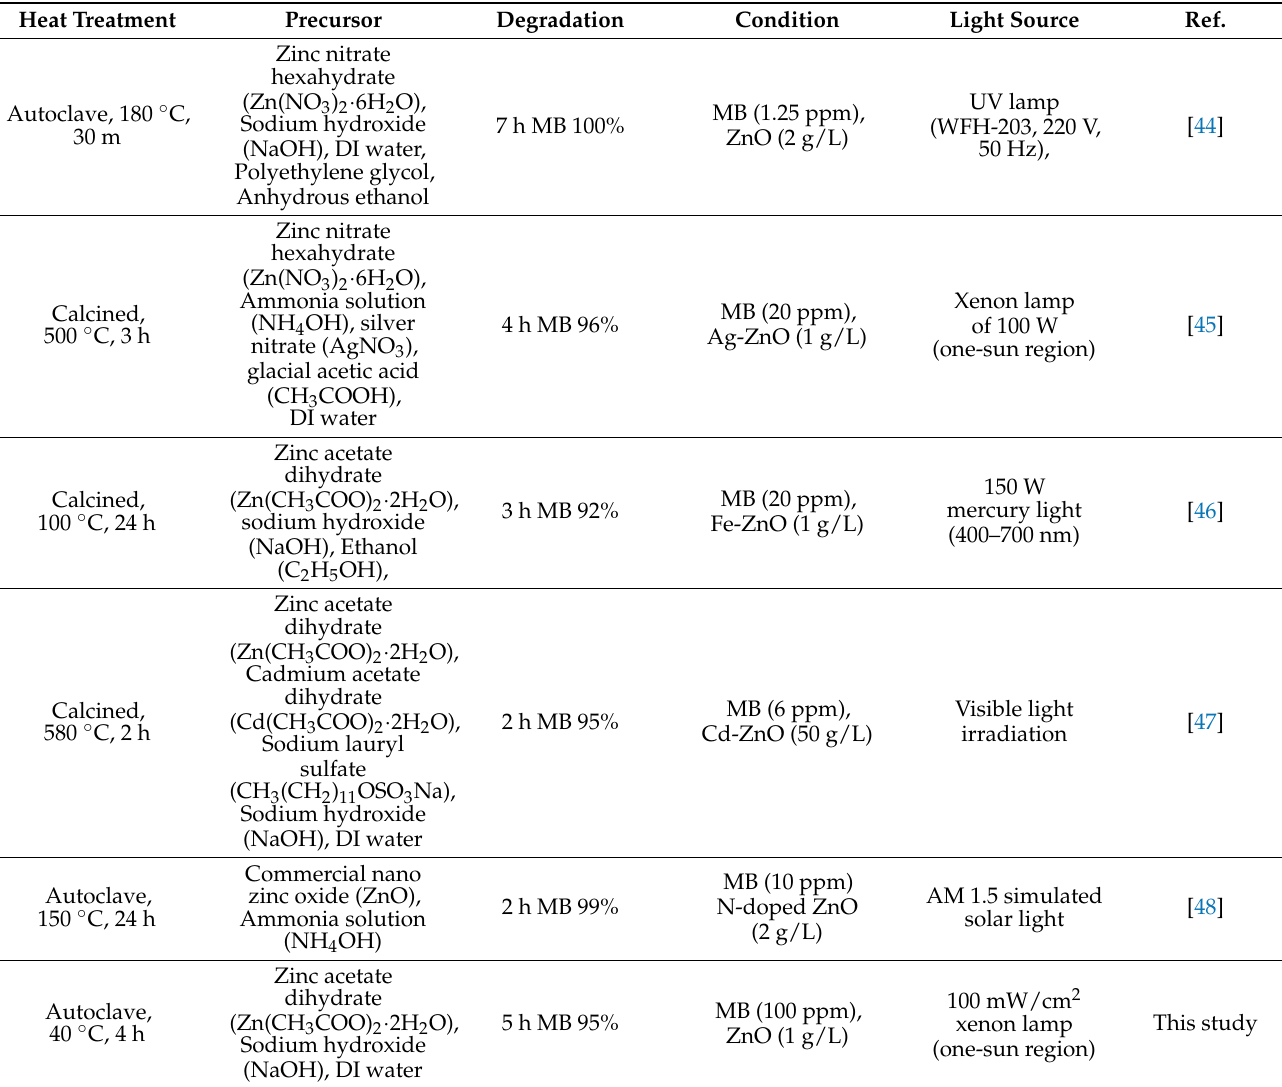
Table 2. Comparison of the photocatalytic degradation of MB under visible light using different catalysts. Condition Light Source